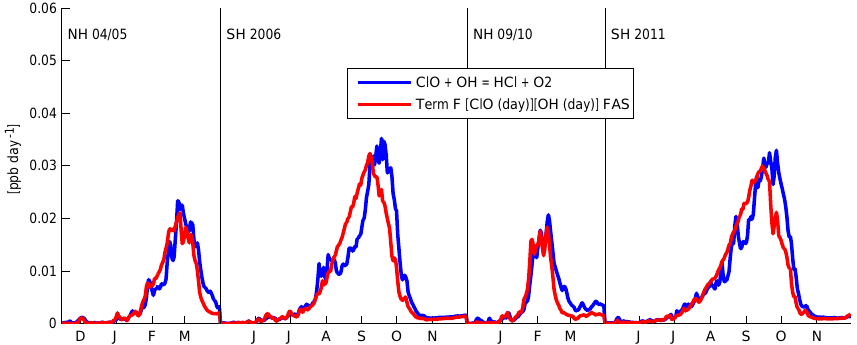
Figure 5. Fit of term F for the Arctic winter 2004/2005, the Antarctic winter 2006, the Arctic winter 2009/2010 and the Antarctic winter 2011 at 54hPa. Vortex-averaged reaction rate modeled by ATLAS for the reaction ClO + OH (blue) and the fitted term F (red). Tick marks on the horizontal axis show start of months.